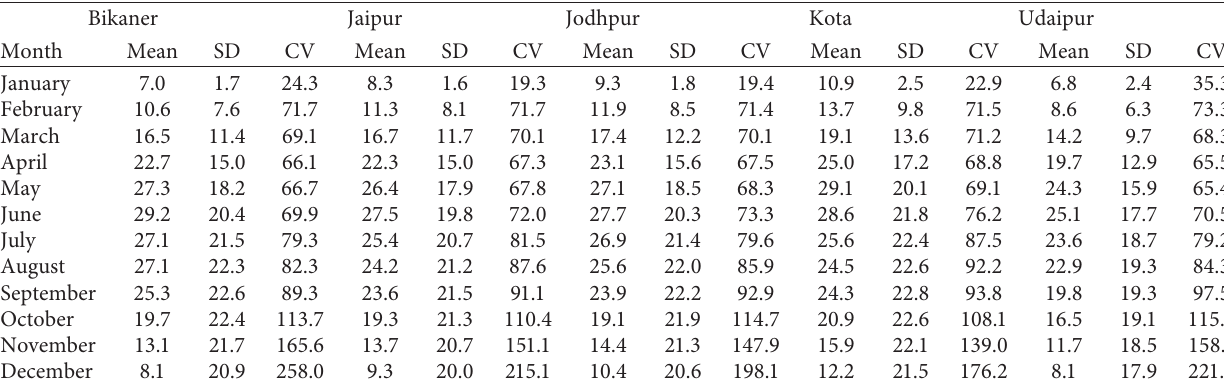
Table 3: Summary statistics for min temperature in ° C (1971–2019) in the districts of Rajasthan. Bikaner Jaipur Jodhpur Kota